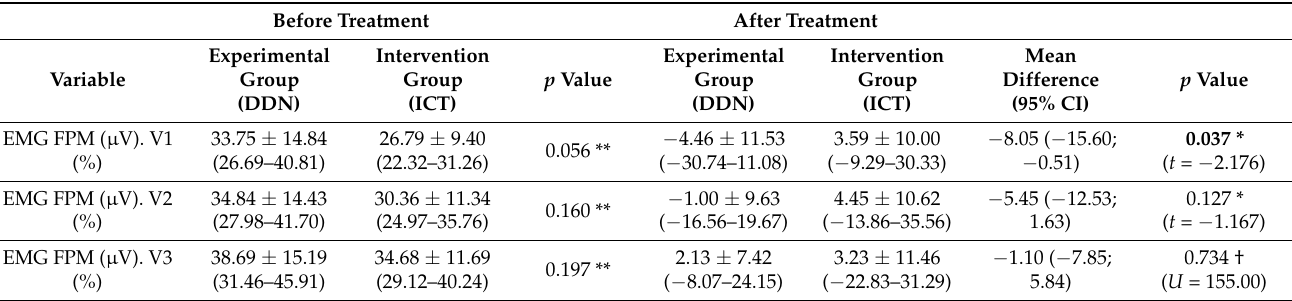
Table 2. Electromyographic measurement of muscle activity in medial or lateral gastrocnemius.